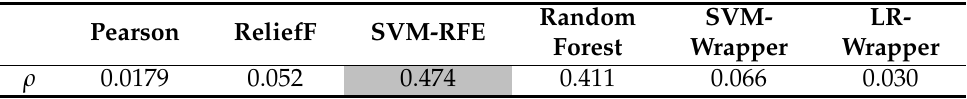
Table 7. Stability of a set with seven full rankings assessed by averaging pairwise similarities with the Spearman’s rank correlation coefficient ( ρ ). In gray background the best